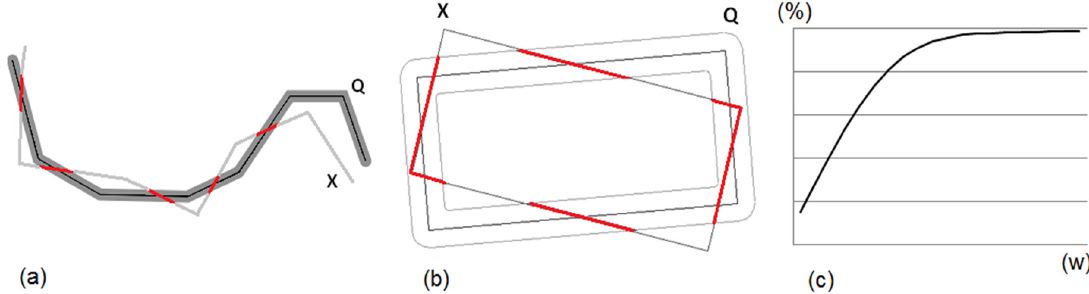
Figure 7. ( a ) Buffer generation by means of single buffer overlay method (SBOM). ( b ) Adaptation to the line-closed case (polygons or plots). ( c ) Empirical probabilistic distribution function.